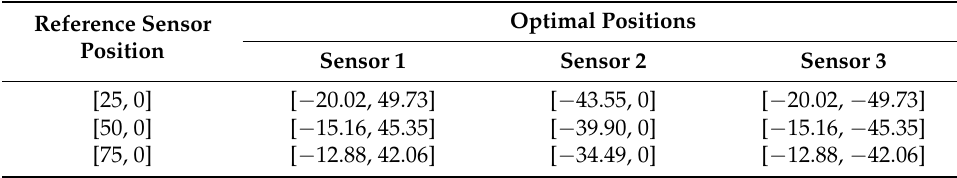
Table 2. Optimal Positions of Sensor AUVs (Single Target: CSP).